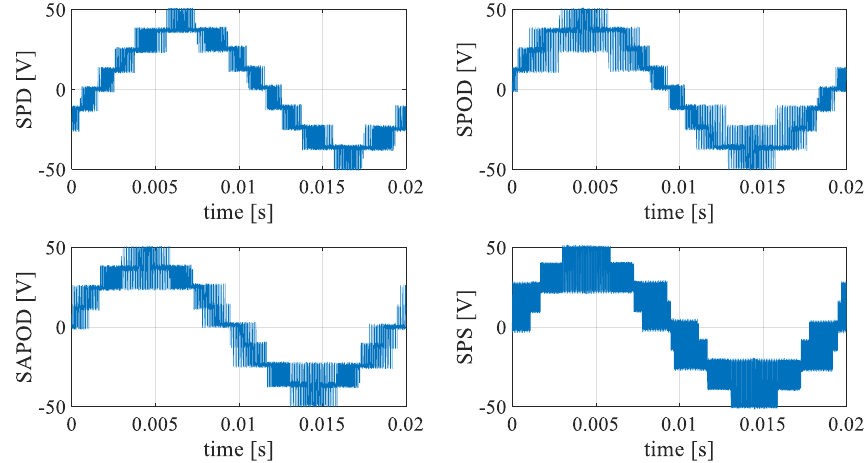
Figure 12. Line voltage waveforms acquired with a modulation index equal to 0.9.